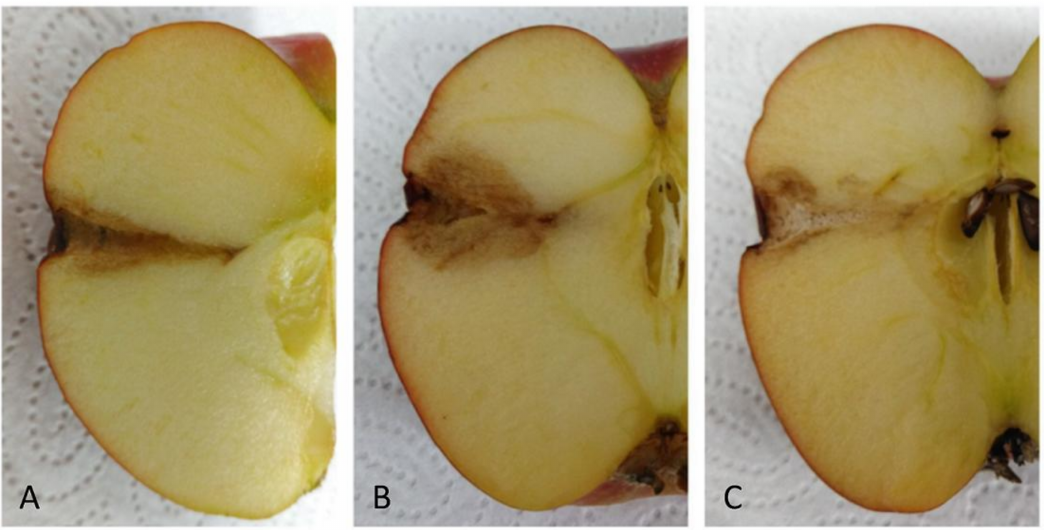
Figure 4. Antagonistic activity on fruits. Apple inoculated with P. odontotermitis OO5 ( A ), B. cinerea B16-14 ( B ), and P. odontotermitis OO5 + B. cinerea B16-14 ( C ). Inoculation with the fungual strain caused a brown lesion zone, which was significantly reduced by co-inoculation with the